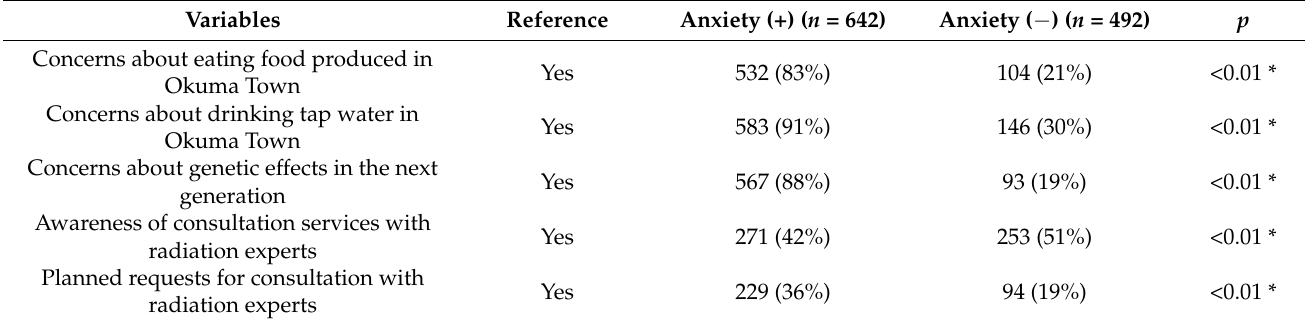
Table 2. Risk perception about health effects of radiation exposure.